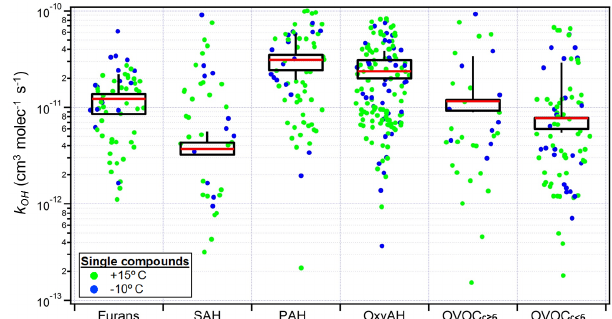
Figure 5. Box plot of mass-weighted average OH reaction rate con- stants ( k OH ) determined for each precursor class from Bruns et al. (2016) for Set 2 only (see Table S3). The individual k OH val- ues for all compounds are also shown for all experiments, colour coded according to the experimental temperatures. The top and bot- tom whiskers represent the 90th and 10th percentiles, while the top, middle and bottom lines of the boxes show the 75th, 50th and 25th percentiles,